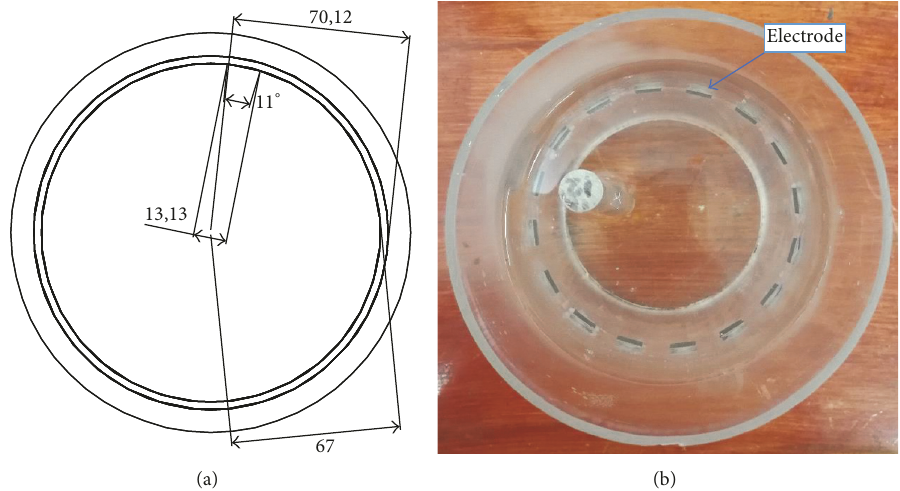
Figure 5: (a) shows the top view dimensions of the testing tank. (b) is the top view of the actual testing